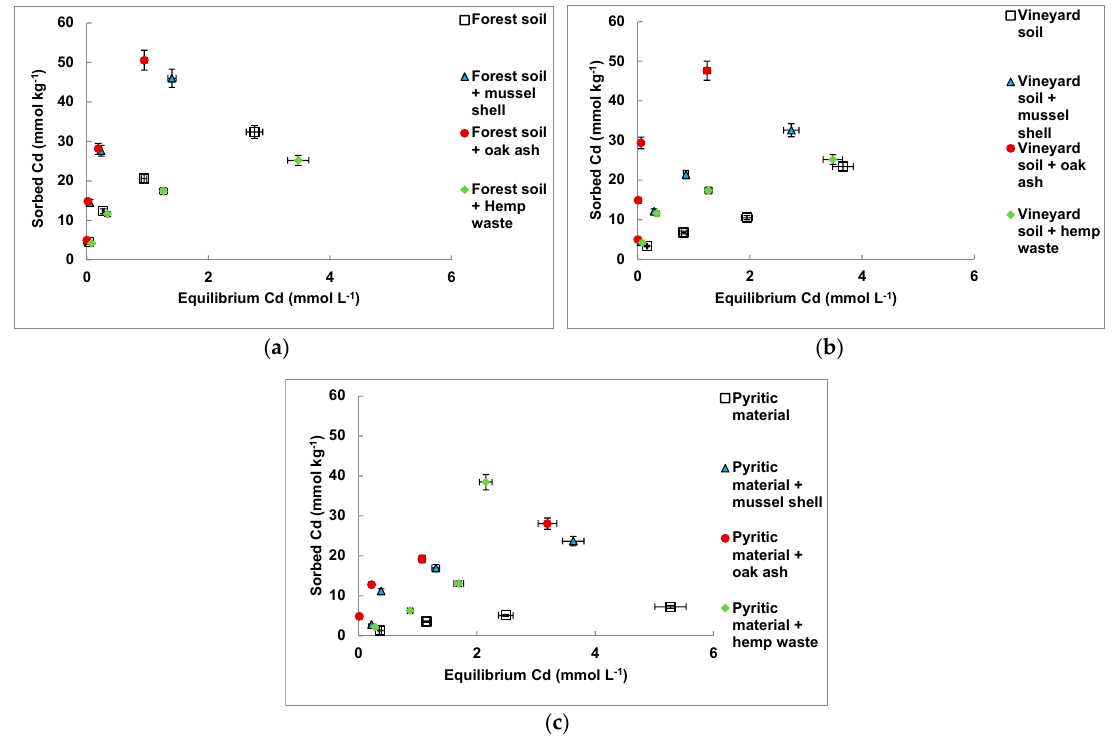
8 of 16 Table 3. Cd and Pb desorption (mmol kg − 1 and %) from the forest soil, vineyard soil, pyritic material and by-products studied. Average values for three replicates, with coefficients of variation always <5%. Sorbent Material